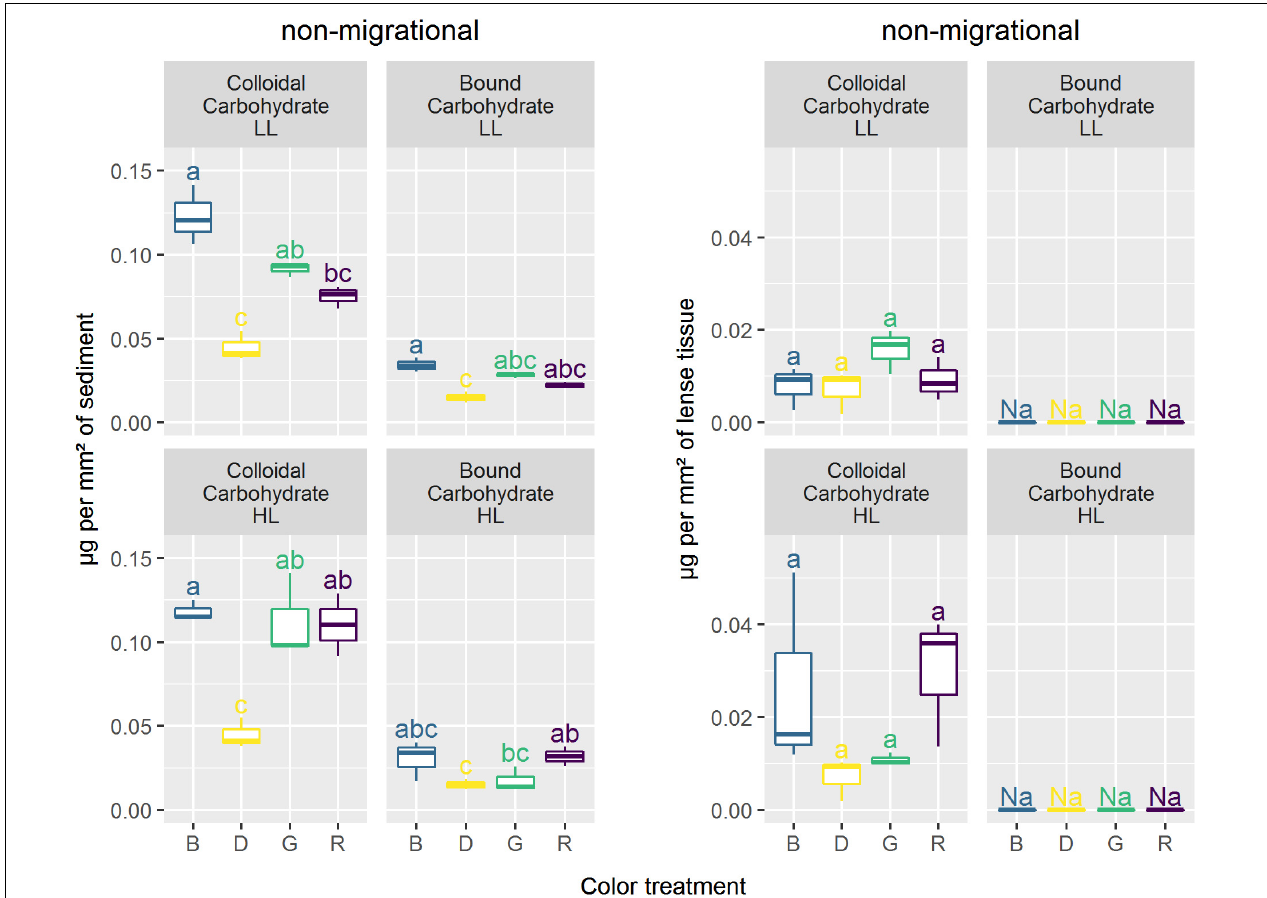
FIGURE 9 | Carbohydrates concentration ( µ g.mm − 2 ) in coloidal and bound fraction for the different lights. Similar letters correspond to treatments not significantly different from Tukey multiple comparisons between colors and intensity within each carbohydrate fraction with an alpha of